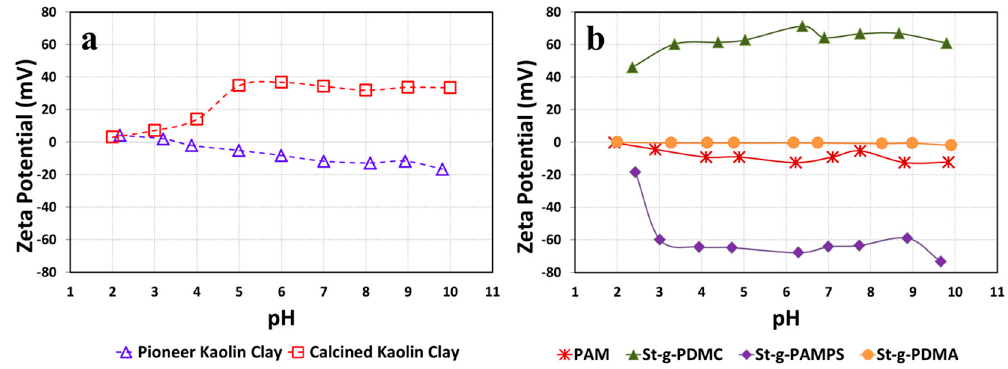
Figure 6. Zeta potentials (ZPs) for ( a ) two types of kaolin clay suspensions and ( b ) various St-g-Polymer and PAM solutions measured on pH range of 2–10.